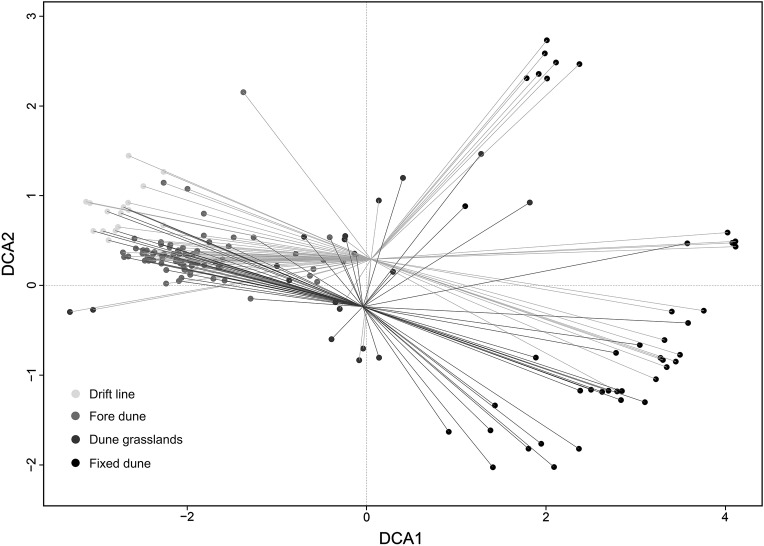
Detrended correspondence analyses scatter diagram of plots (grouped in the four habitat types), using species as explanatory variables. Only the first two axes are represented. Light grey lines represent the relevés sampled in 1989–90; dark grey lines represent the relevés sampled in 2010–12.